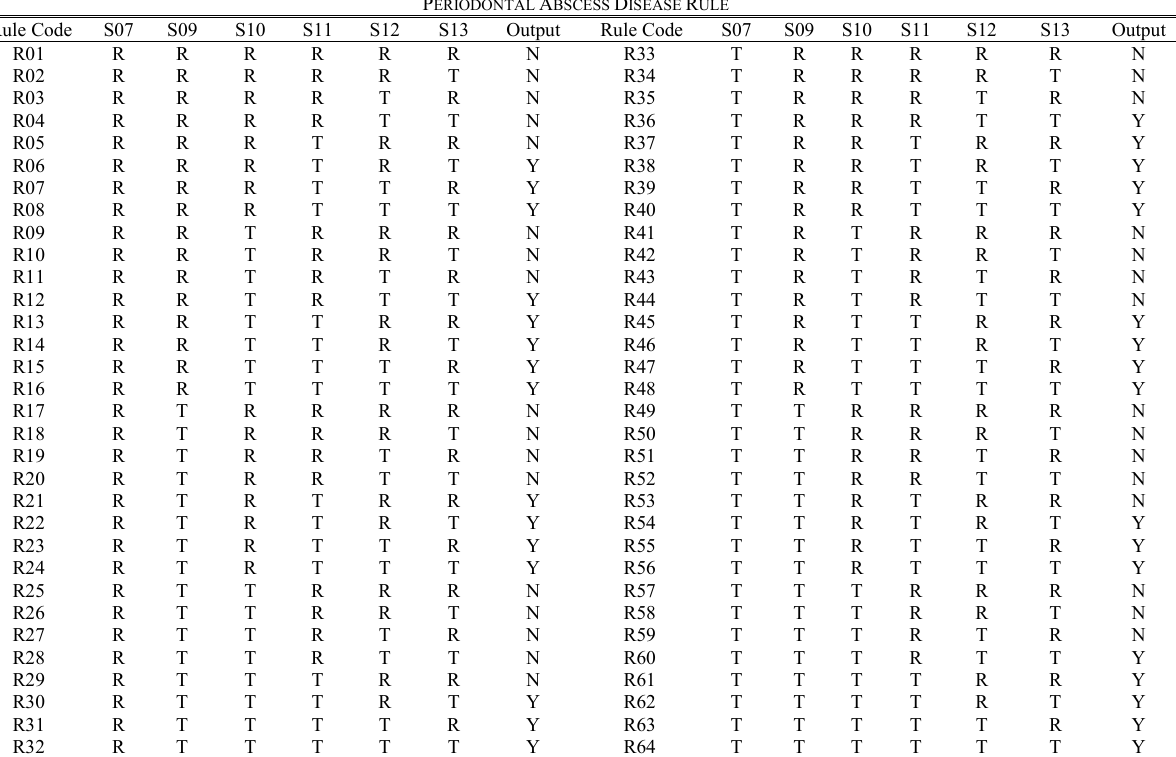
TABLE 5 P ERIODONTAL A BSCESS D ISEASE R ULE